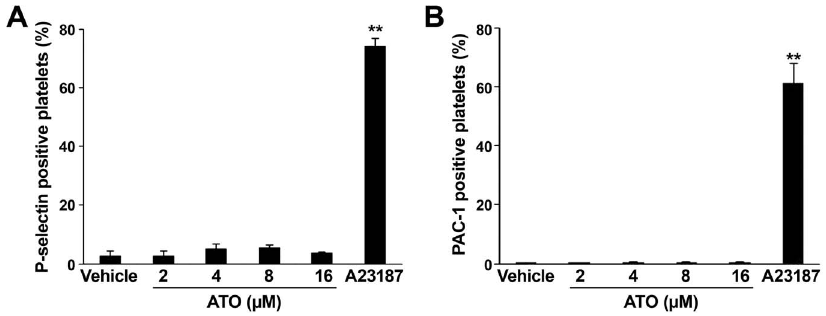
Figure 4. ATO does not incur P-selectin surface expression and PAC-1 binding in platelets. Washed Platelets were treated with different concentrations of ATO (2, 4, 8, 16 m M) or vehicle at 37 u C for 5 hrs. (A) Pre-treated platelets were further incubated with SZ51 or mouse IgG at RT for 30 min, and then incubated with FITC-GAM and subjected to flow cytometry analysis. Quantitation data from three separate experiments with different donors are shown as mean 6 SD. (B) Pre-treated platelets were further incubated with FITC-labeled soluble PAC-1 at RT for 20 min in the dark, then the treated platelets were fixed with 1% cold paraformaldehyde, further incubated at 4 u C in the dark for 30 min and then subjected to flow cytometry detection. Quantitation data from three separate experiments with different donors are shown as mean 6 SD ( n =3). ** P , 0.01 compared with vehicle controls.